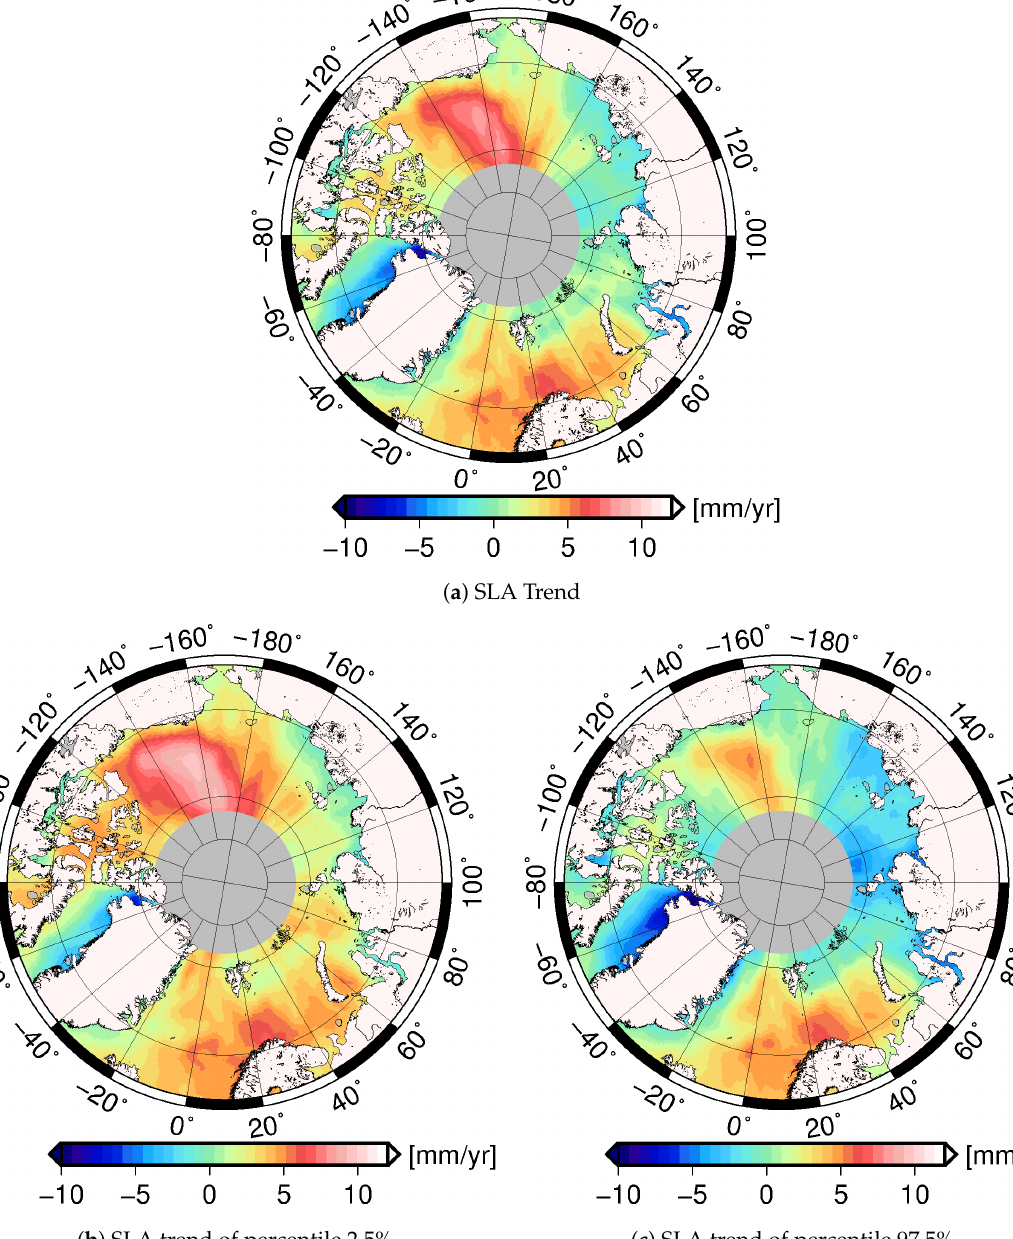
Figure 5. ( a ) The CCI DTU/TUM SLA trends from January 1996 to September 2018 given in mm/year. ( b , c ) show the SLA trend uncertainty in the same period. There is found a 95% confidence interval of the SLA trend within ( b , c